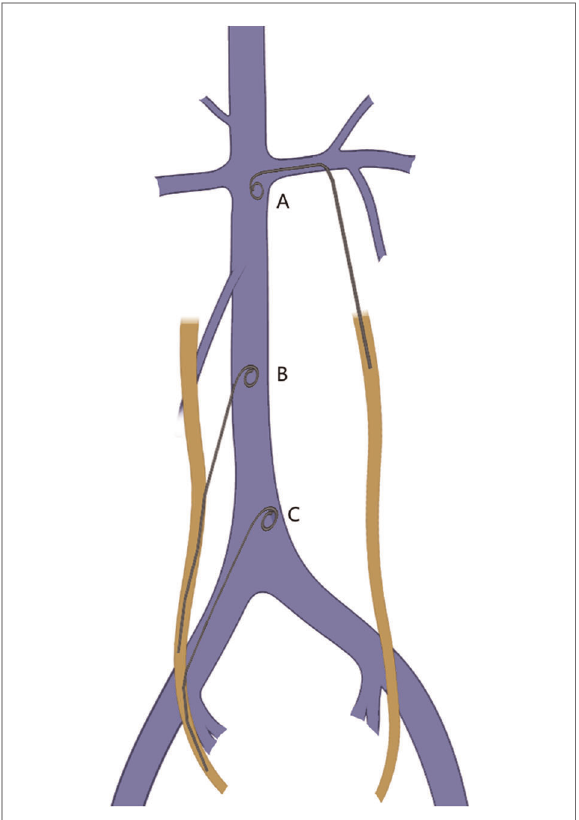
FIGURE 4 Common pathways for double J stents (DJSs) to enter the inferior vena cava (IVC). ( A ) through the left renal vein; ( B ) directly breaking into the IVC through the right ureter; ( C ) migration to the IVC via the right iliac